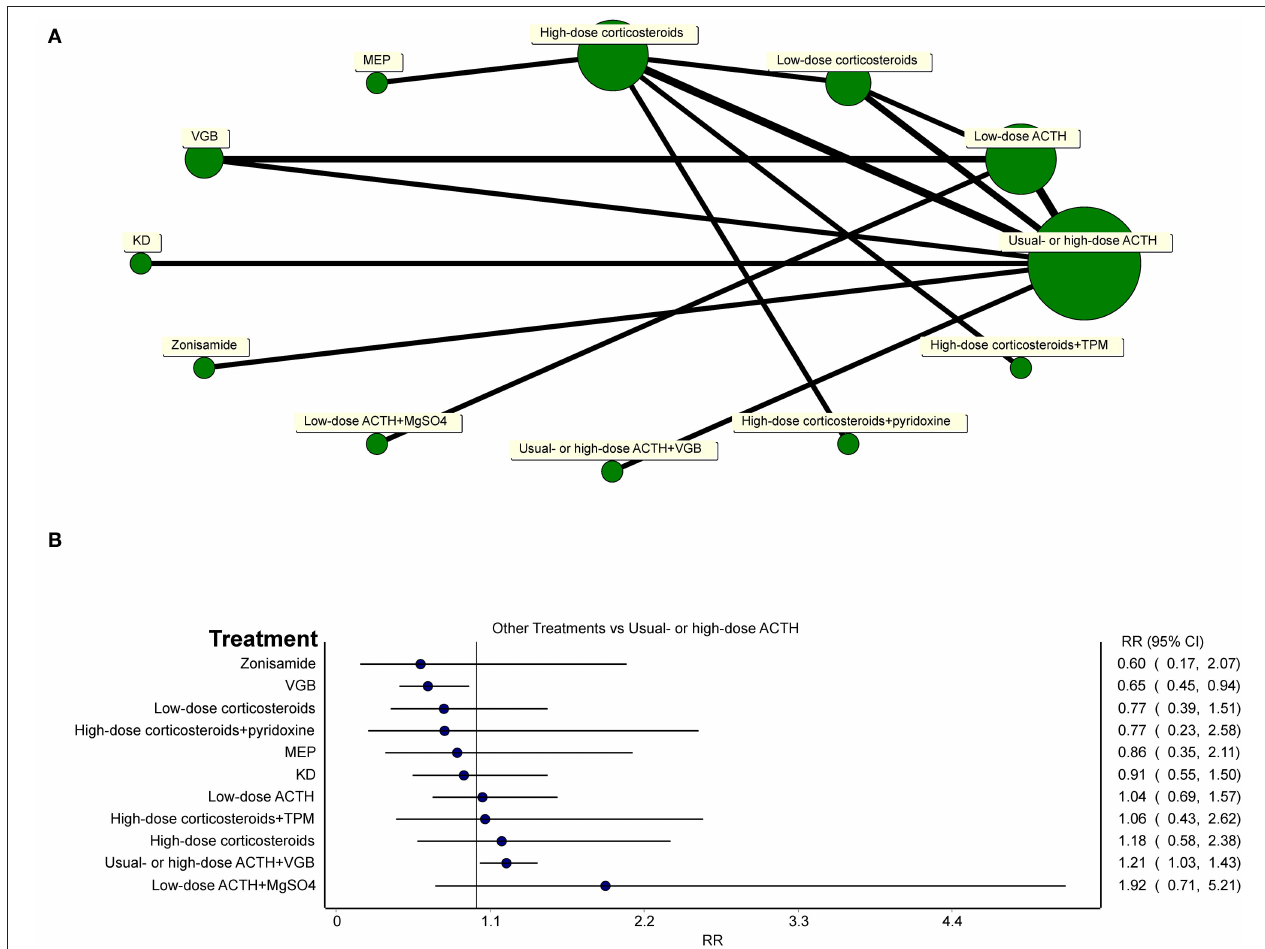
FIGURE 7 | (A) Network of all treatments of included randomized controlled trials. (B) Network meta-analysis of all other treatments vs. usual-dose ACTH in the effectiveness of the electro-clinical response.